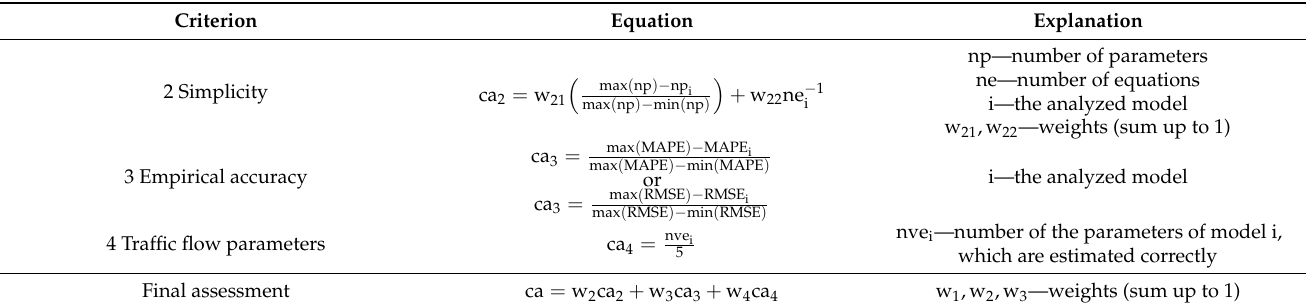
Table 4. Formulas for model assessment and comparison—criteria 2, 3 and